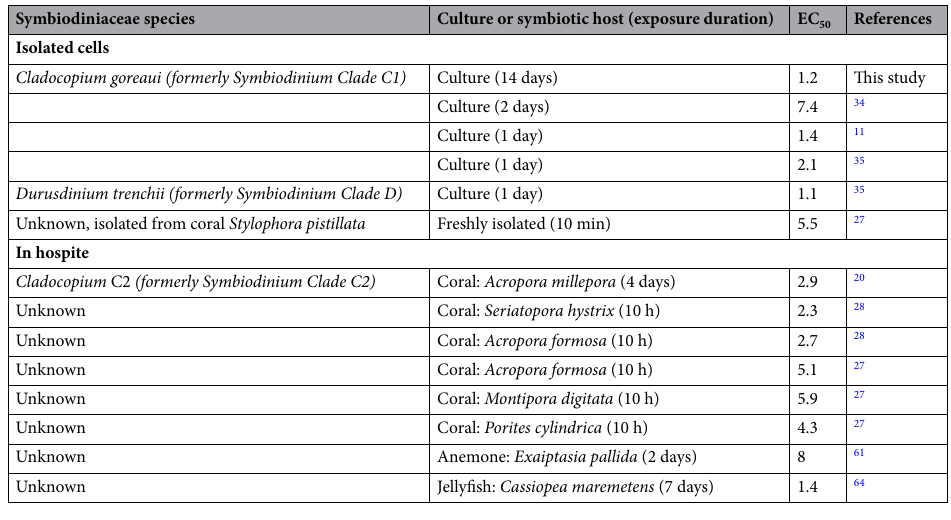
Table 4. Comparison of EC 50 values derived for ΔF/F m ′ in Symbiodiniaceae exposed to diuron . EC 50 values for ΔF/F m ′ in Symbiodiniaceae in cultured and freshly isolated cells and in symbiosis ( in hospite ). EC 50 in µg L −1